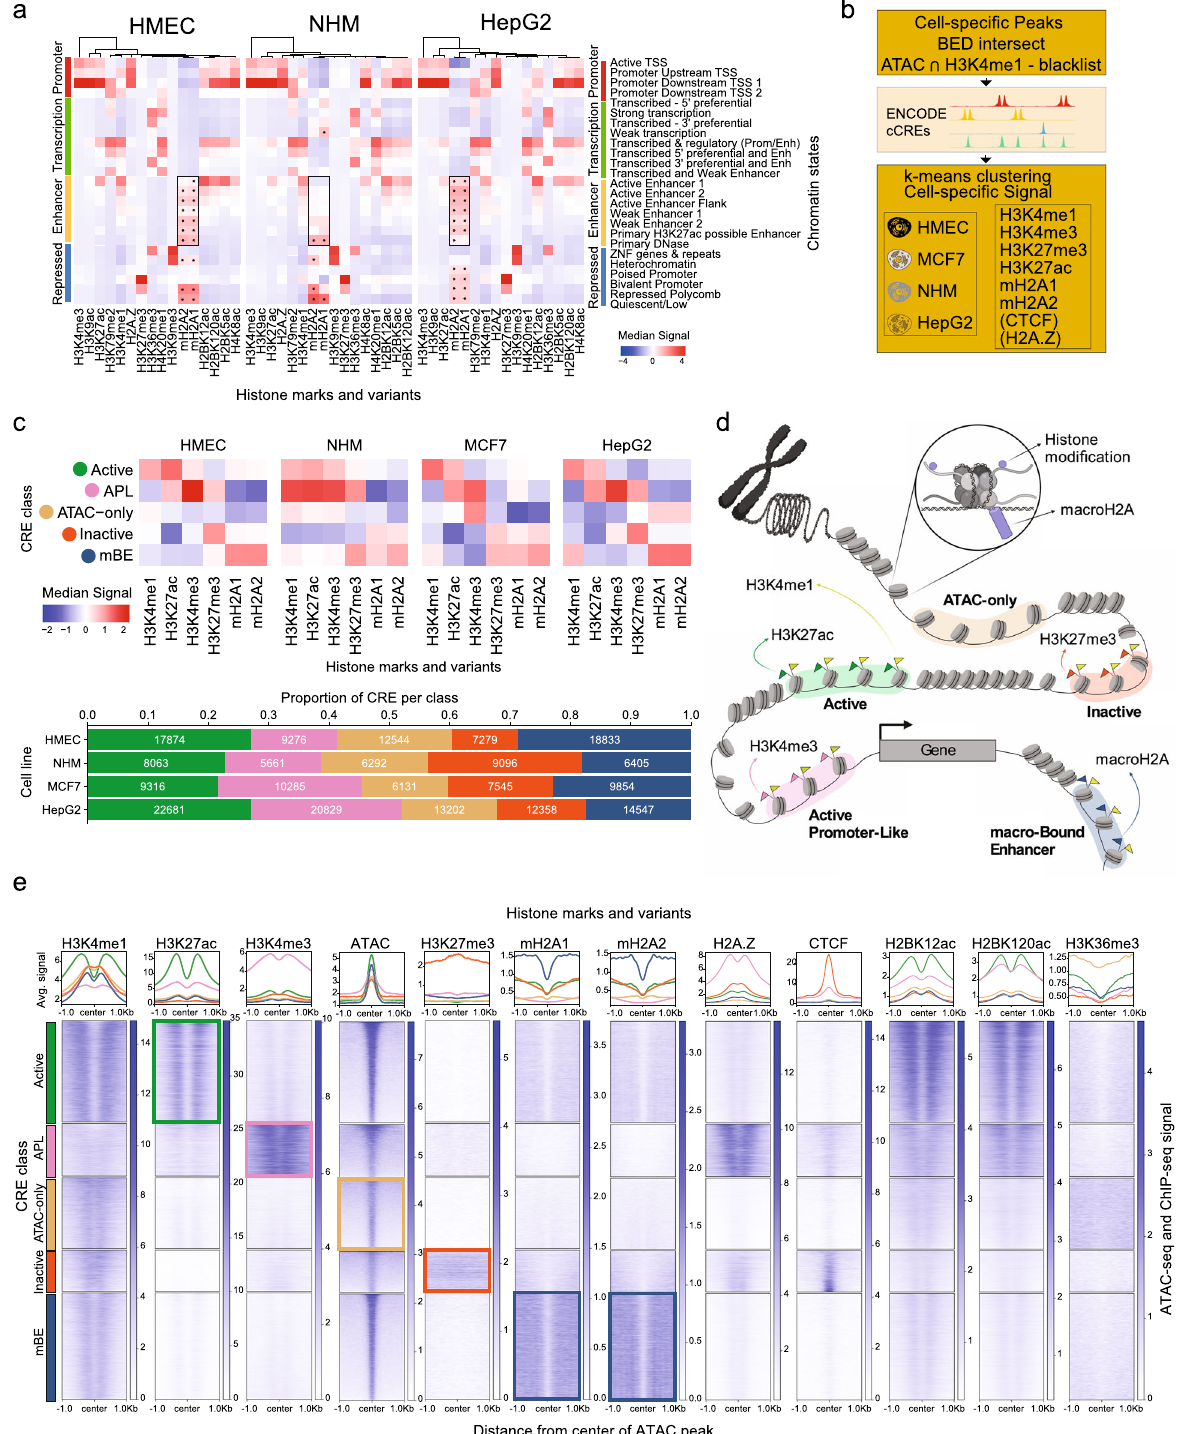
Fig. 1 Characterization of macro-Bound Enhancers. a Heatmaps showing median signal scores of 14 histone marks from the Roadmap reference human epigenomes (imputed ChIP-Seq signal tracks for E119, E059 and E118) and that of histone variants macroH2A.1 and macroH2A.2 (signal tracks from ChIP-Seq experiments), across all genomic regions in the 25-state chromatin models from Roadmap, built for human mammary epithelial cells (HMEC), normal human melanocytes (NHM) and the human hepatocellular carcinoma cell line (HepG2), respectively. All values are centered and scaled along the column direction. Median signal scores of macroH2A variants in the enhancer states are highlighted using a box. MacroH2A variants enrichments that are statistically signi fi cant ( p < 0.05, one-sided Mann – Whitney U test with Bonferroni correction) are marked with an asterisk. b Outline of algorithm used to classify cell-speci fi c cis - regulatory elements (CRE). c Heatmaps showing median Z scores of the log-normalized input-corrected ChIP-seq signal of 6 histone marks/variants used in classifying the CRE sites in each CRE class (top). Bar plot (bottom) shows the proportion of CRE classes in each cell type. d Illustration showing each CRE class with corresponding marks (histone modi fi cations or variants). e Average signal pro fi le (top) and heatmaps (bottom) of ATAC-seq signal scores, and ChIP-seq signal scores of histone marks and variants around open chromatin regions (de fi ned by ATAC-seq) grouped by the fi ve CRE classes in HMEC. COMMUNICATIONS BIOLOGY| (2023) 6:215